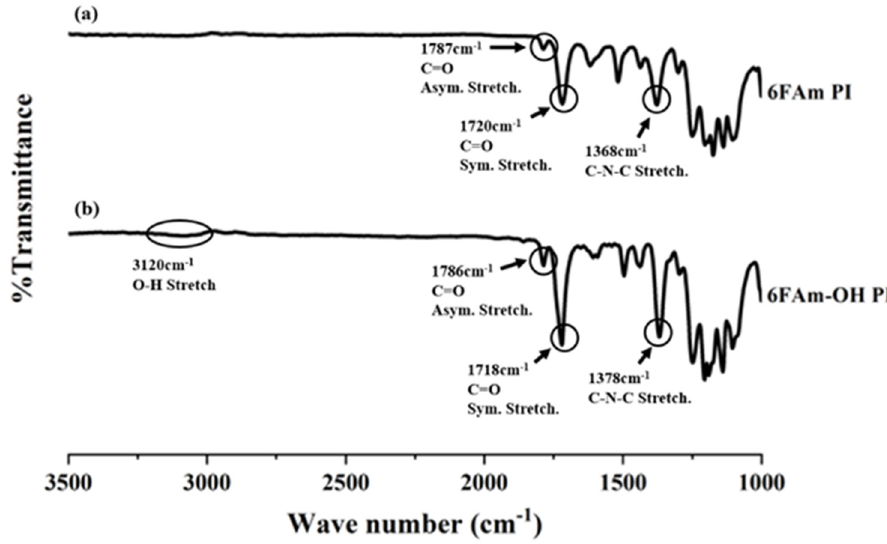
Figure 1. FTIR spectra of pure CPI films containing ( a ) 6FAm and ( b ) 6FAm-OH.